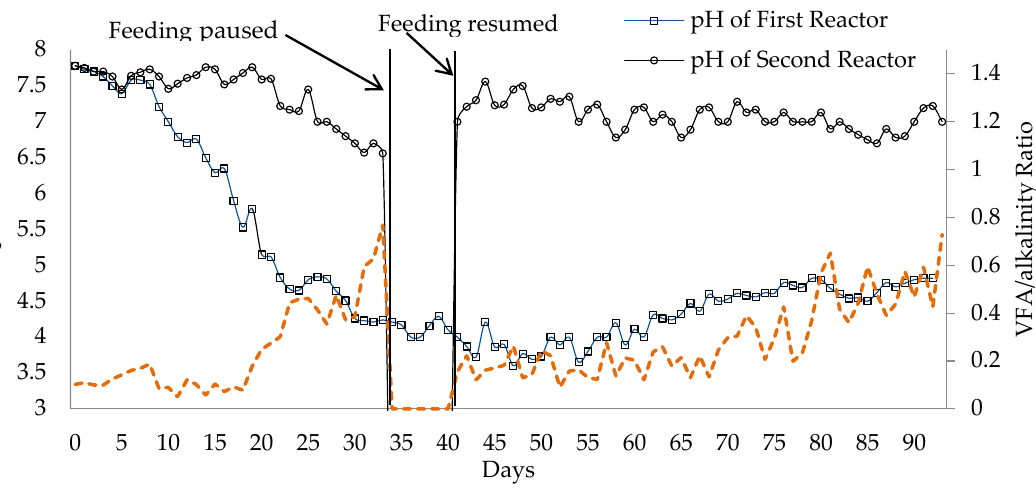
Figure 3. Record of change in FOS: TAC ratio and pH along with time representing the first reactor and second reactor throughout the operation.